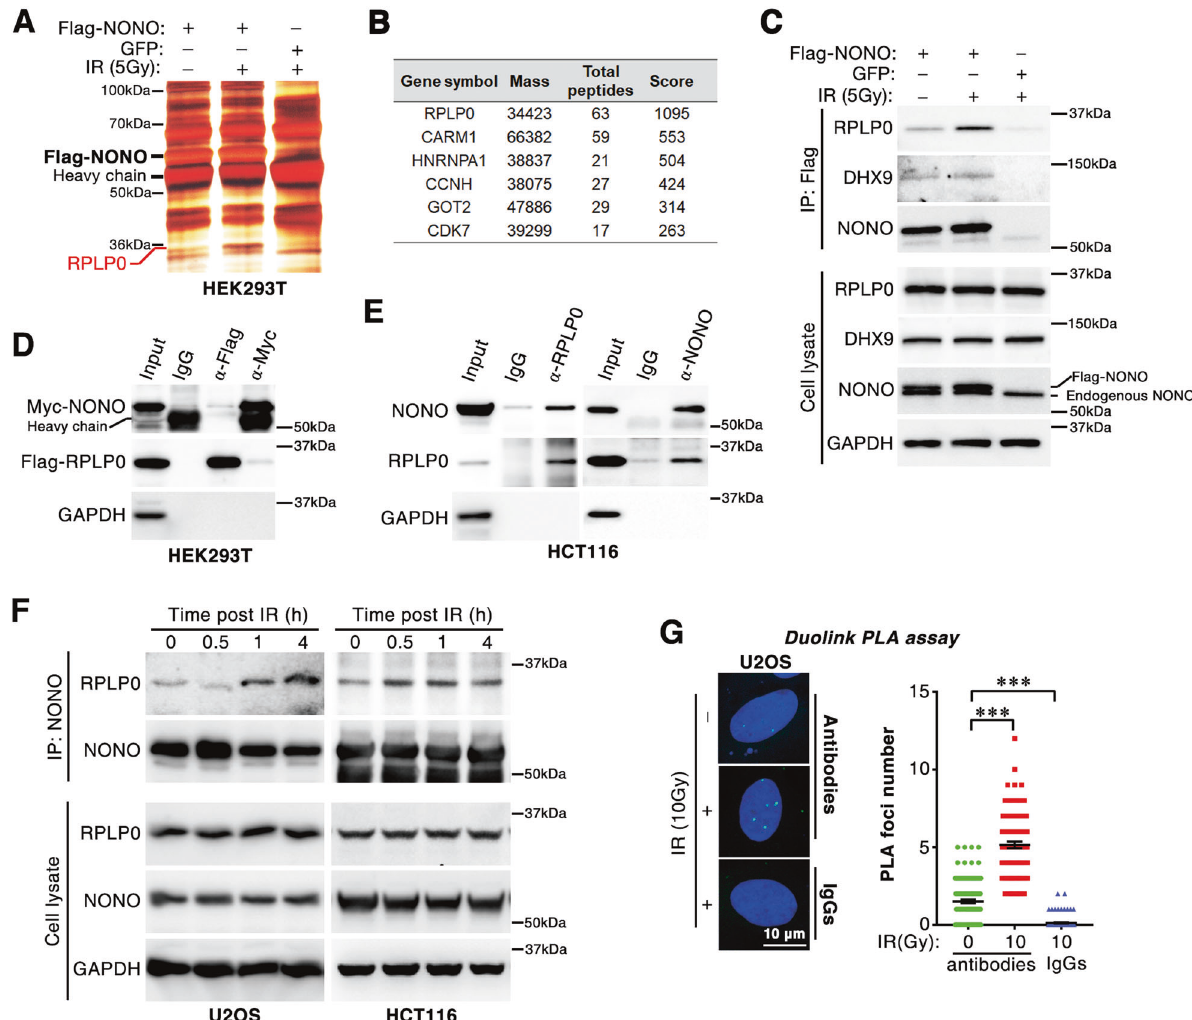
Fig. 1 Irradiation increases the association between NONO and ribosomal protein RPLP0. A Screening of IR-induced NONO-binding protein. HEK 293T cells were transfected with indicated plasmid and treated with IR (5 Gy). After recovery (30 min), the protein interacting with NONO was assessed by CoIP, separated with SDS-PAGE, and identi fi ed with LC/MS assay. GFP was used as a negative control. B The differentially expressed band at 36 kDa in Fig. 1A was analyzed by LC/MS. C The sample in Fig. 1A was analyzed with western blotting. D Flag- RPLP0 and Myc-NONO were interacted with each other in HEK 293T cells. Twenty-four hours after transfection with Flag-RPLP0 and Myc- NONO plasmid, cells were subjected to CoIP assay with anti-Myc or anti-Flag antibodies. E endogenous RPLP0 and NONO are associated